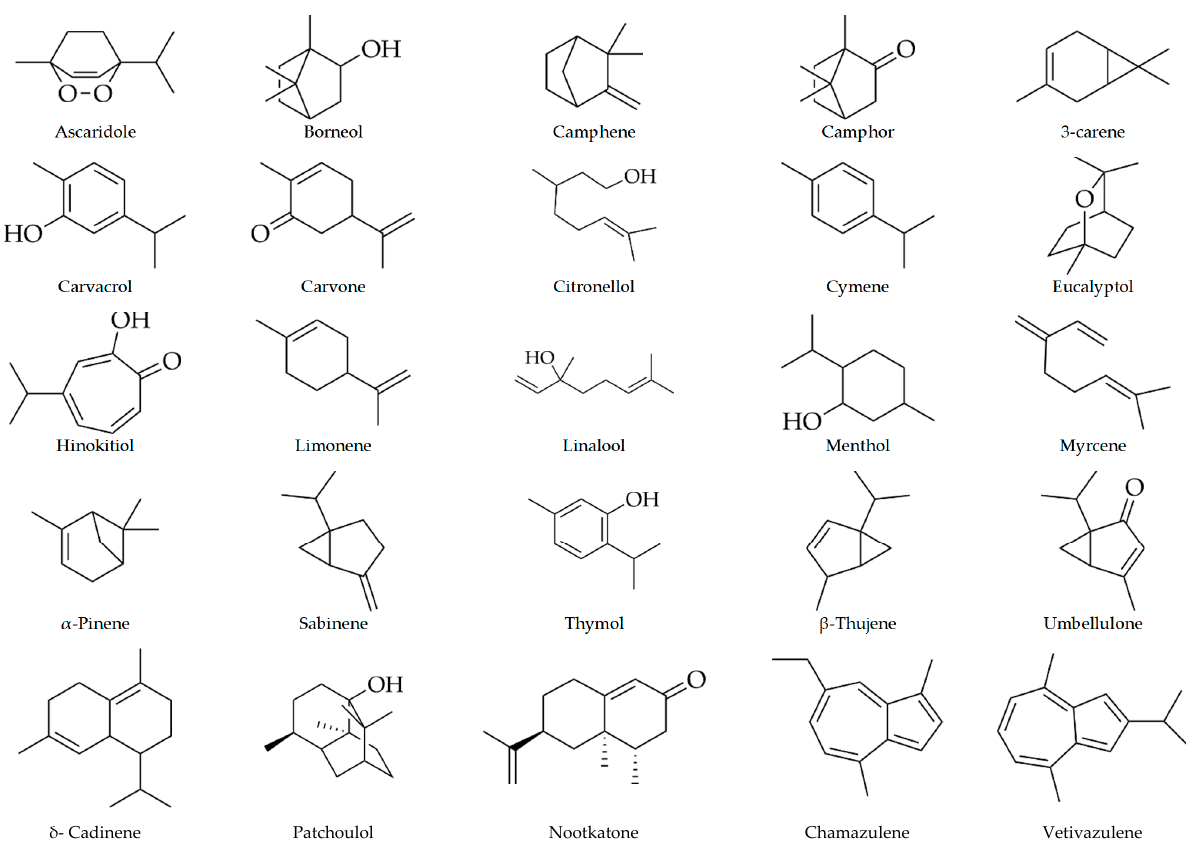
Figure 1. Some monoterpenoids and sesquiterpenoids presented in essential